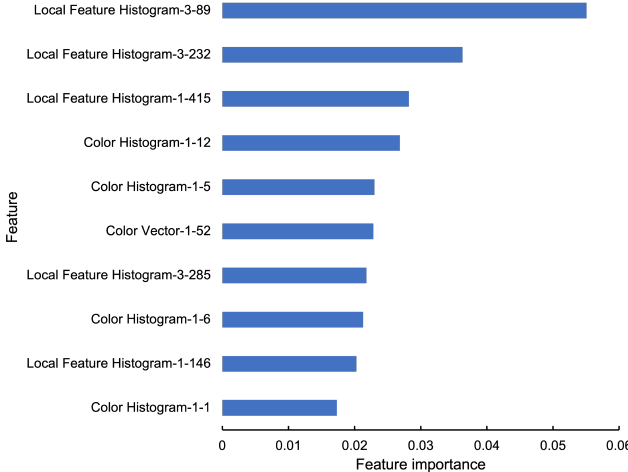
Figure 6. Most important features in the proposed method.